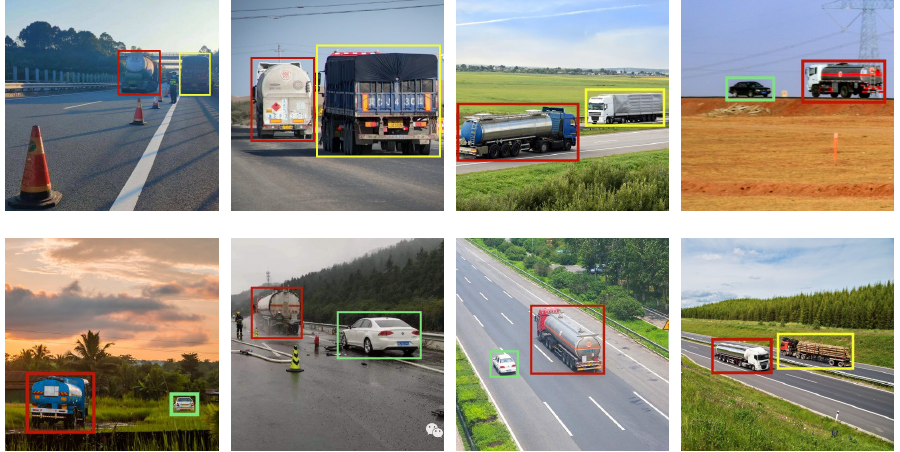
Figure 13. A subset of multiple categories vehicle detection